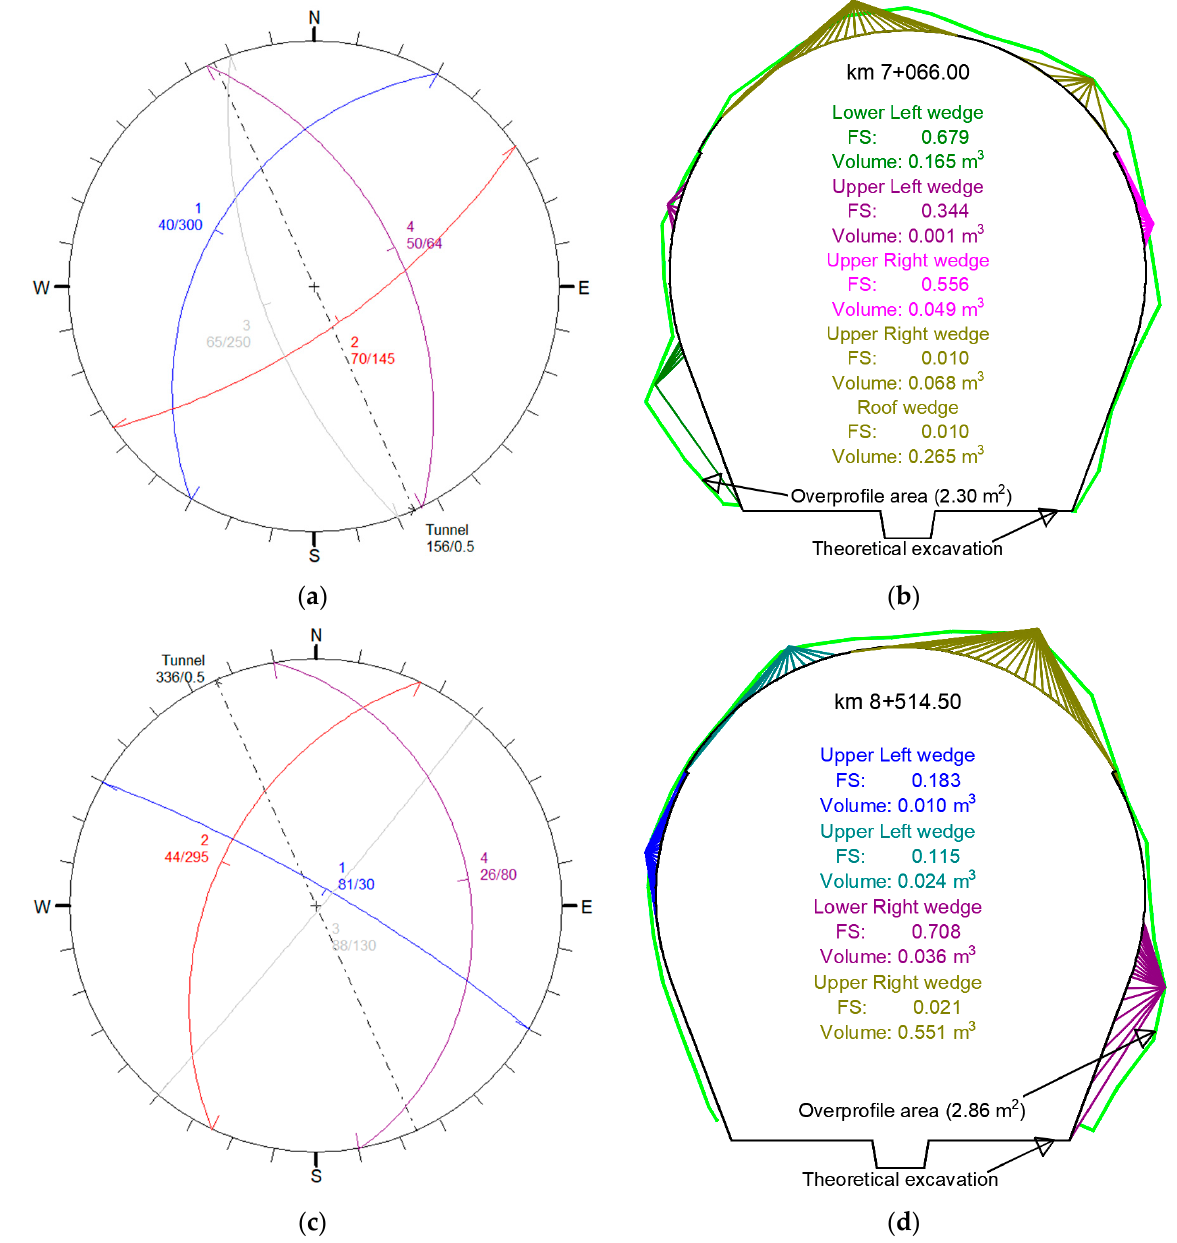
Figure 7. Results of deterministic analysis at two selected sections: km 7 + 066.00 and km 8 + 514.50 ( a , c ) Measured orientation of wedges on contour diagram; ( b , d ) dimensions and positions of unstable wedges and overlap with observed excessive excavation (green line) for the two sections.